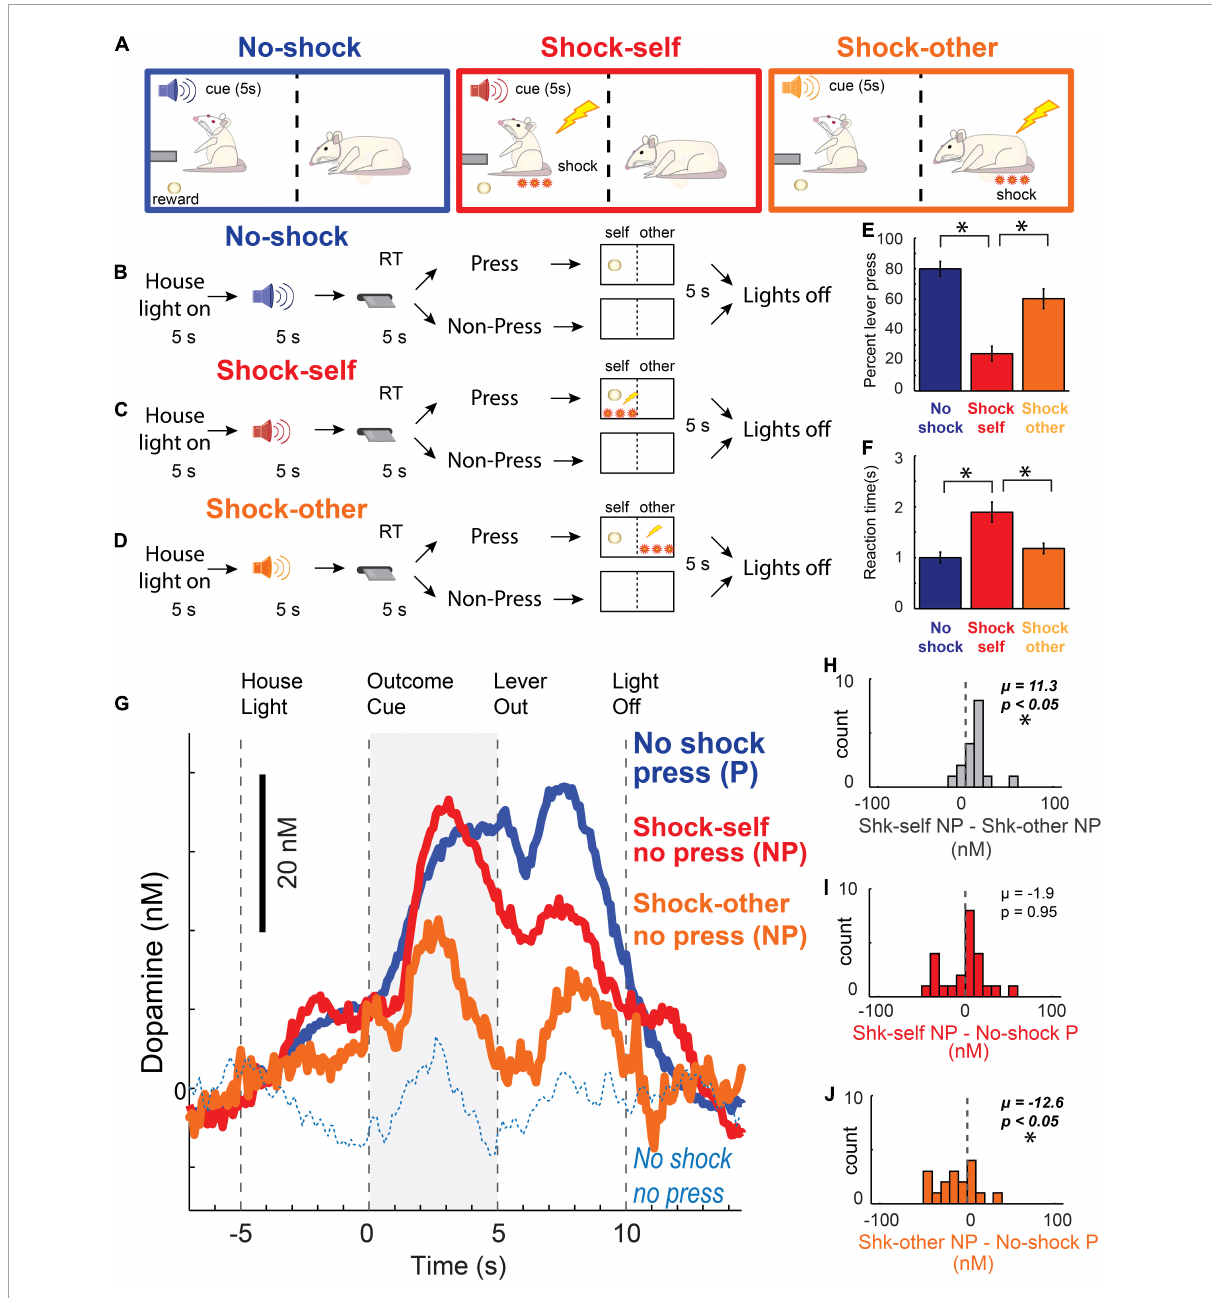
FIGURE5 (A–D) Instrumental social distress task design. Recording rats were presented with a lever 5 s after presentation of 1 of 3 different auditory stimuli. Lever pressing always led to sucrose reward, but on some trials, different auditory stimulus predicted that lever-pressing would also lead to shock delivery – either to oneself (red; Shock-Self), or to the conspecific (orange; Shock-Other). After lever extension, rats had 5 s to press; otherwise, the lever retracted and no outcomes were delivered. Thus, on “Shock-Self” trials, if the recording rat pressed, it received reward and shock. On “Shock-Other” trials, if the recording rat pressed, it received reward and the conspecific was shocked. If they did not press on “Shock” trials, they avoided shock for themselves or the conspecific (depending on the trial-type), at the cost of not receiving reward. On “No-Shock” trials recording rats pressed the lever for reward with no threat of shock to oneself or the conspecific (blue). (E) Percentage of lever presses per trial type. (F) Latency to lever-press. (E–F) Wilcoxon, p < 0.05. (G) Dopamine release (nM) in NAc over time (s) across each trial type. Blue solid = recording rat pressed the lever for reward; Blue dashed = recording rat failed to press the lever for reward; Red = recording rat did not press during shock-self trials, thus avoided shock for oneself and forfeited reward on that trial; Orange = recording rat avoided shock to the conspecific at the cost of giving up reward for oneself. (H–J) Indices of DA release for each trial type during the outcome cue epoch (gray bar in G ) across sessions: (H) shock self ( no press ) minus shock other ( no press ); (I) shock self ( no press ) minus no shock ( press ); (J) shock other ( no press ) minus no-shock ( press ). (H–J) Asterisks denote significant shifts from zero; Wilcoxons, p < 0.05. Adapted from Lichtenberg et al.